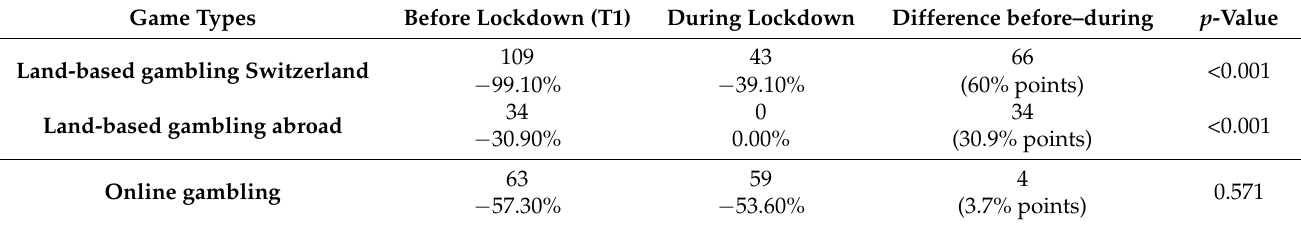
Table 2. Participation in Online and Offline Gambling Before and During Lockdown ( n =